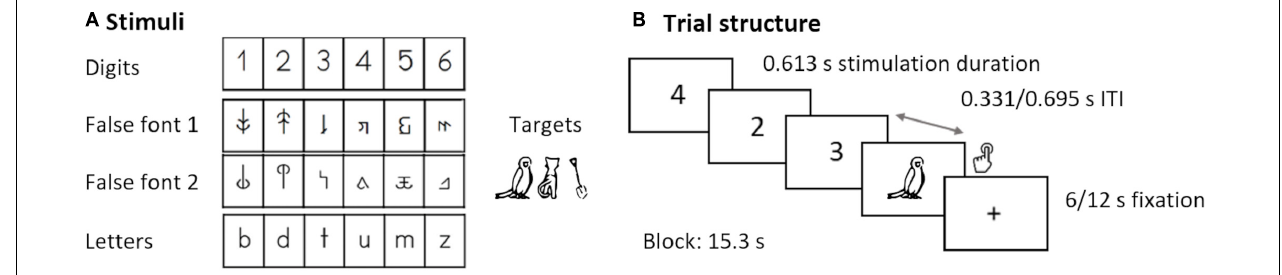
FIGURE 2 | Target detection task. (A) Digits, false fonts, letters, and target stimuli. (B) Trial structure and presentation